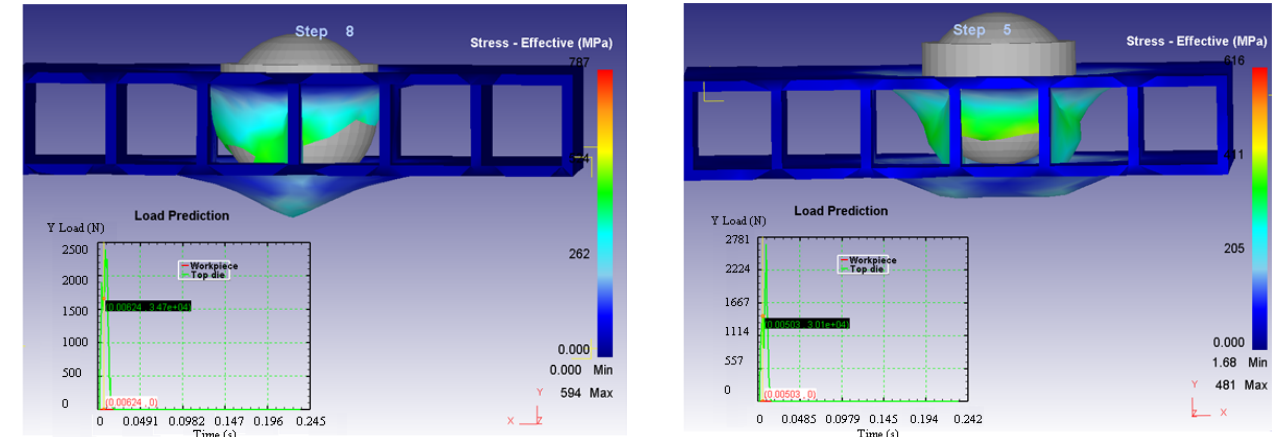
Figure 15. Stress-effective efforts—Y axes in the two considered cases.